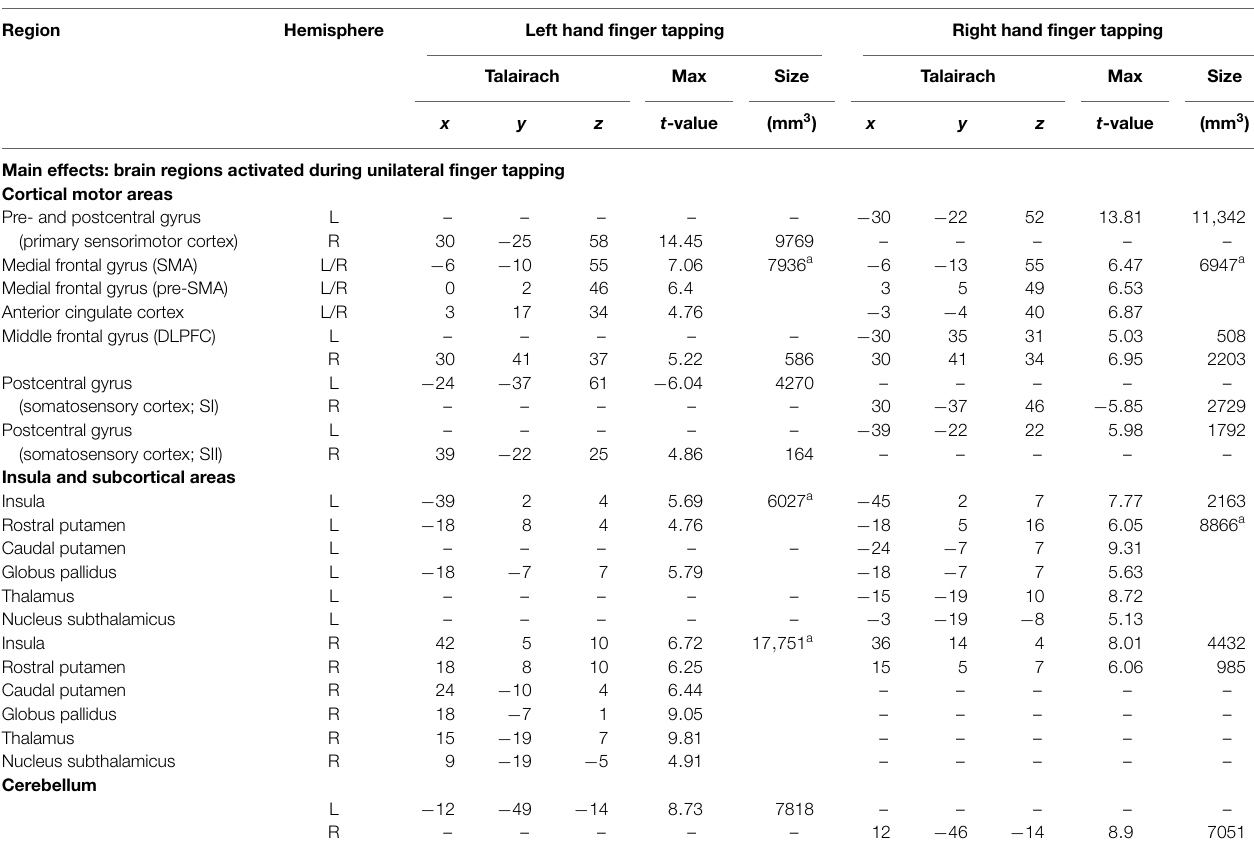
TABLE 1 | Whole brain random effects group analysis .